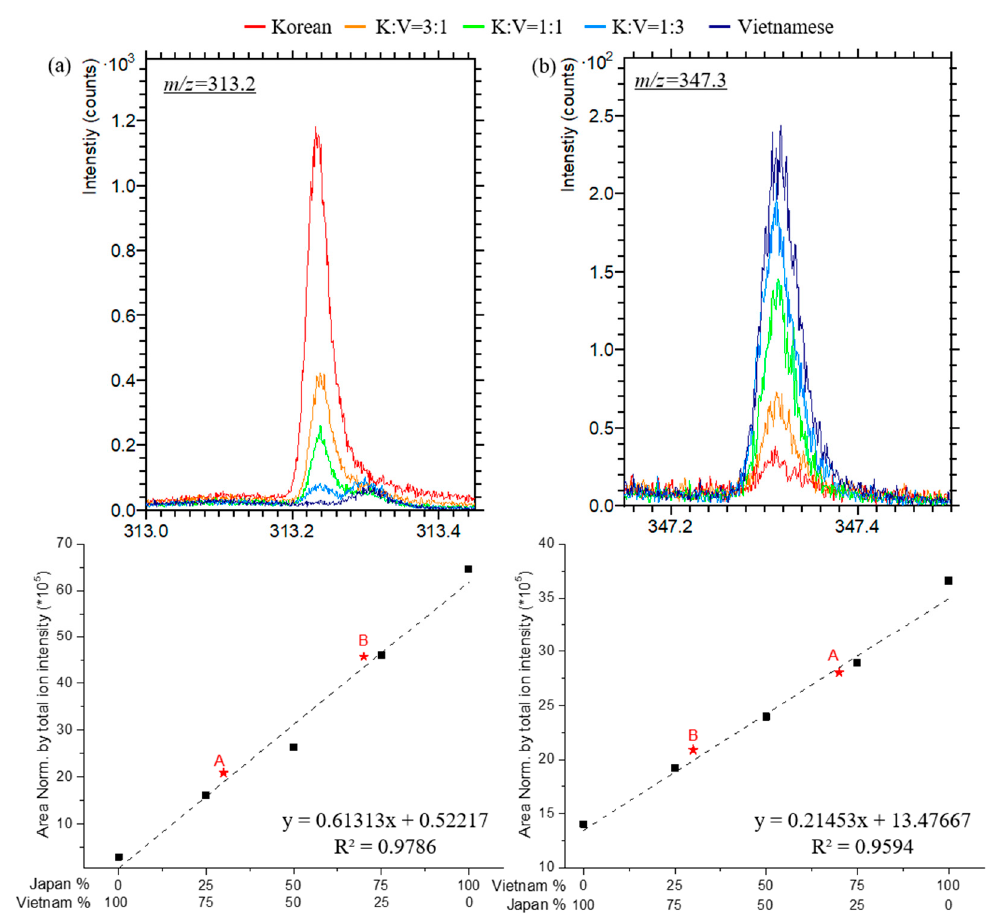
Figure 2. Calibration curves of the compositional ratios of blended Japanese and Vietnamese lacquer films in accordance with the detected ion species using ToF–SIMS: ( a ) urushiol ion ( m/z = 313) and ( b ) laccol ion ( m/z = 347).